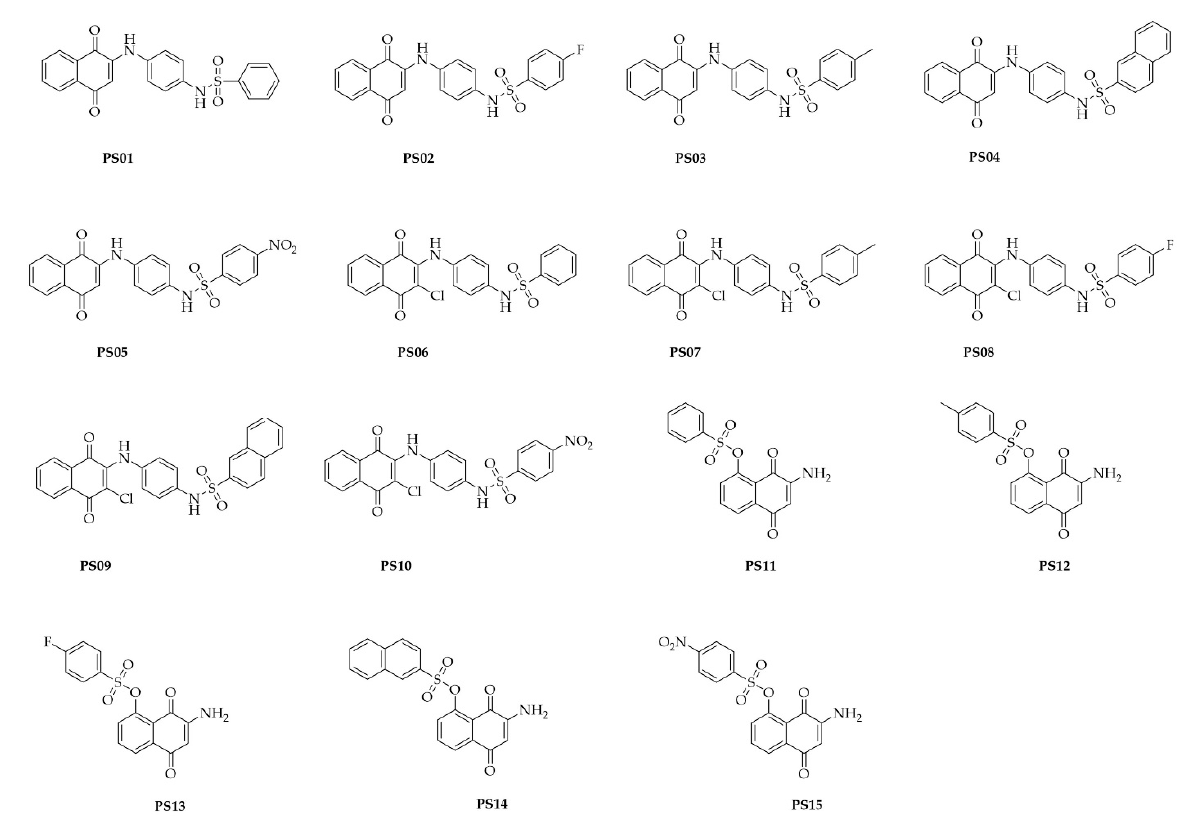
Figure 1. Chemical structures of naphthoquinone sulfonamide and sulfonate ester derivatives tested in this study.